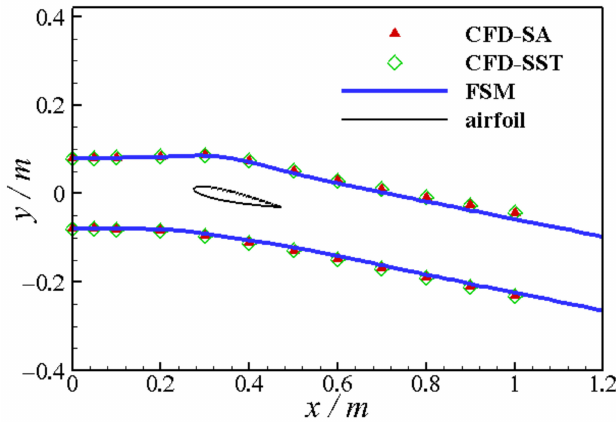
Figure 14. Comparison of the jet deflection with different